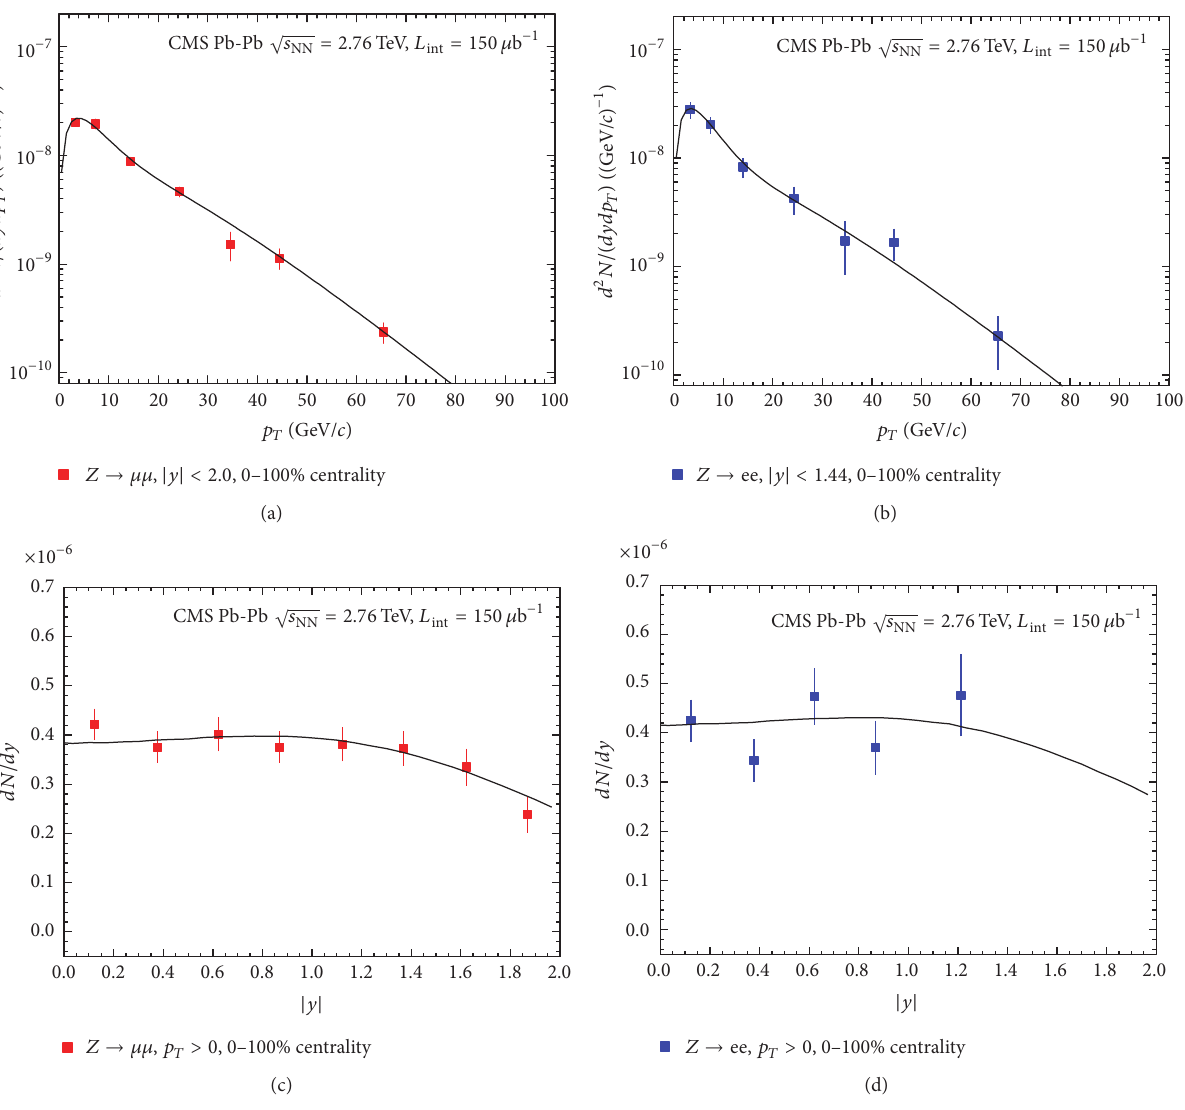
Figure 2: Same as Figure 1, but showing the results in Pb-Pb collisions with 0–100% centrality at √𝑠 NN = 2.76 TeV, where the per-event yield 𝑁 on the vertical axis is used instead of the cross section 𝜎 , and 𝐿